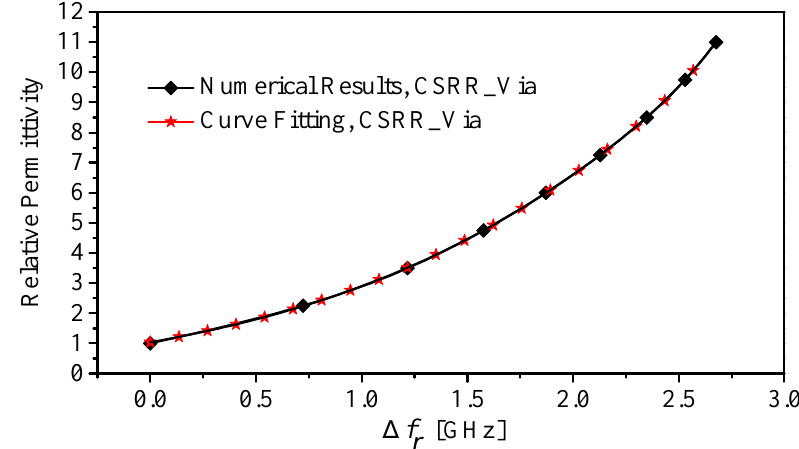
Figure 9. The relative permittivity versus the resonance frequency shift using the numerical simula- tion (HFSS) and the curve fitting.